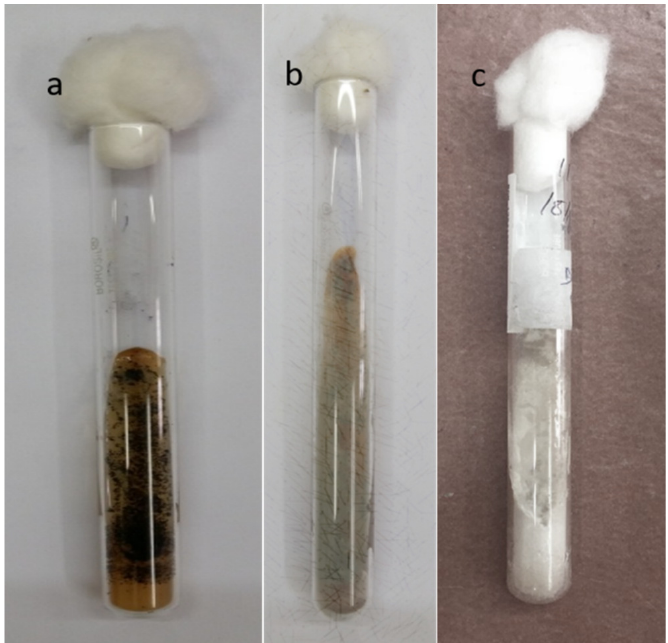
Figure 3. Sabouraud’s Dextrose Agar showing growth of moulds of various colours ( a ) black colonies of Aspergillus niger. ( b ) slate green colonies of Penicillium spp. ( c ) cream colonies of Fusarium spp.